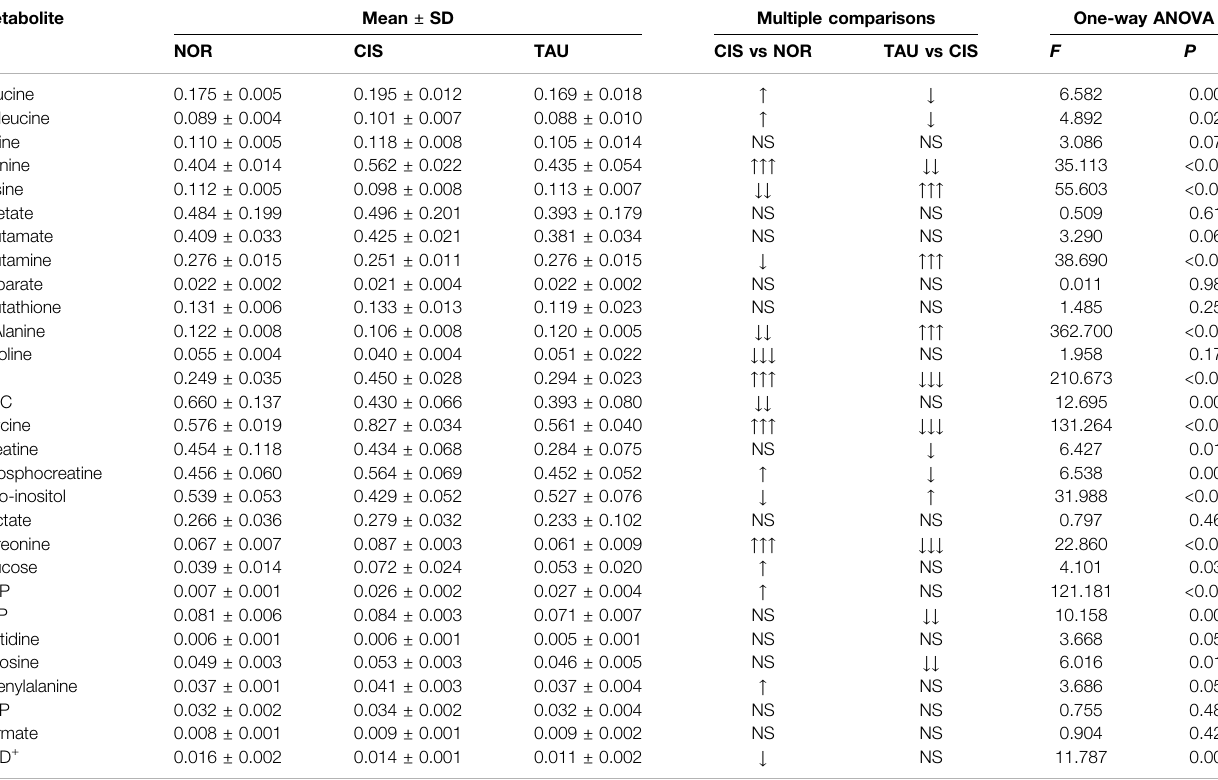
TABLE 2 | Multiple comparisons of metabolite levels among the NOR, CIS, and TAU groups of C2C12 myoblasts based on relative NMR